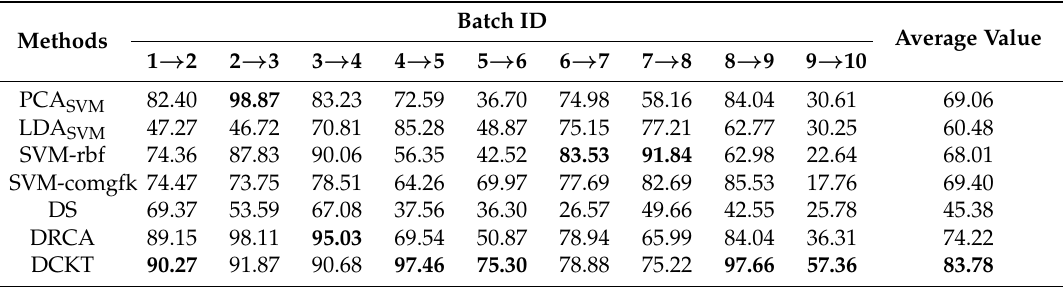
Table 4. Recognition accuracy (%) under Experimental Setting